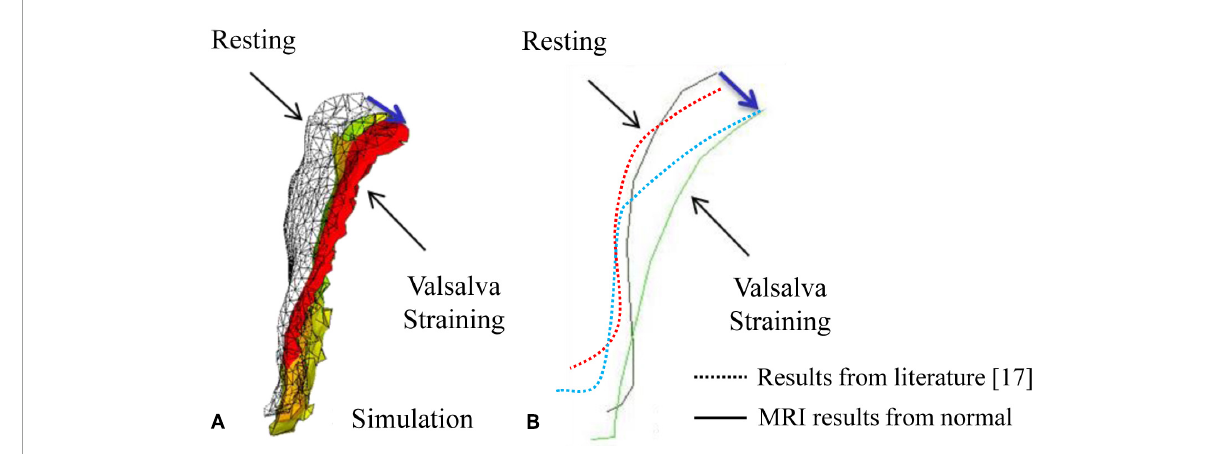
FIGURE5 Displacement of the anterior vaginal wall during the Valsalva maneuver: (A) Results from our simulation; (B) Results from a previous study (12) and dynamic magnetic resonance imaging